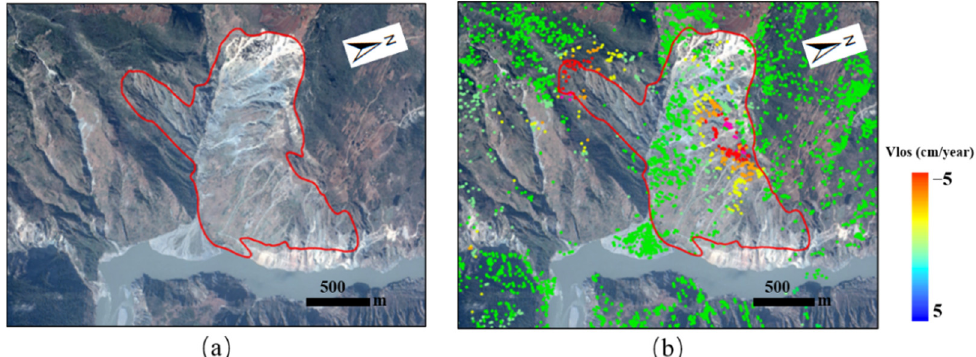
Figure 8. Identification result (red polygons) of the SLT landslide with the OBIA method by using a purely optical image ( a ), and by integrating the optical image with the InSAR − derived deformation map ( b ).